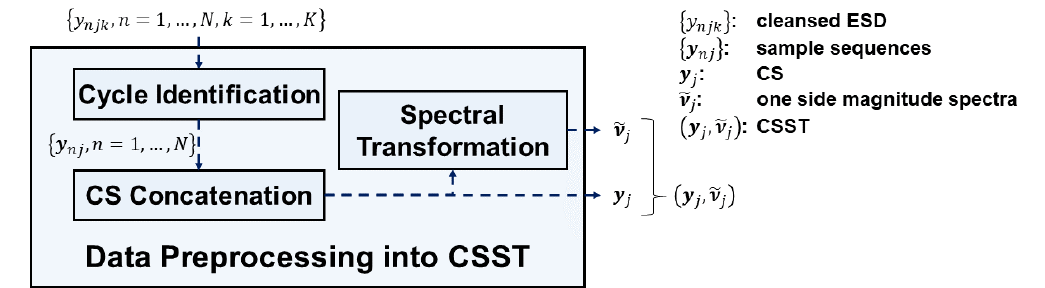
Figure 5. The data preprocessing module in STALAD.